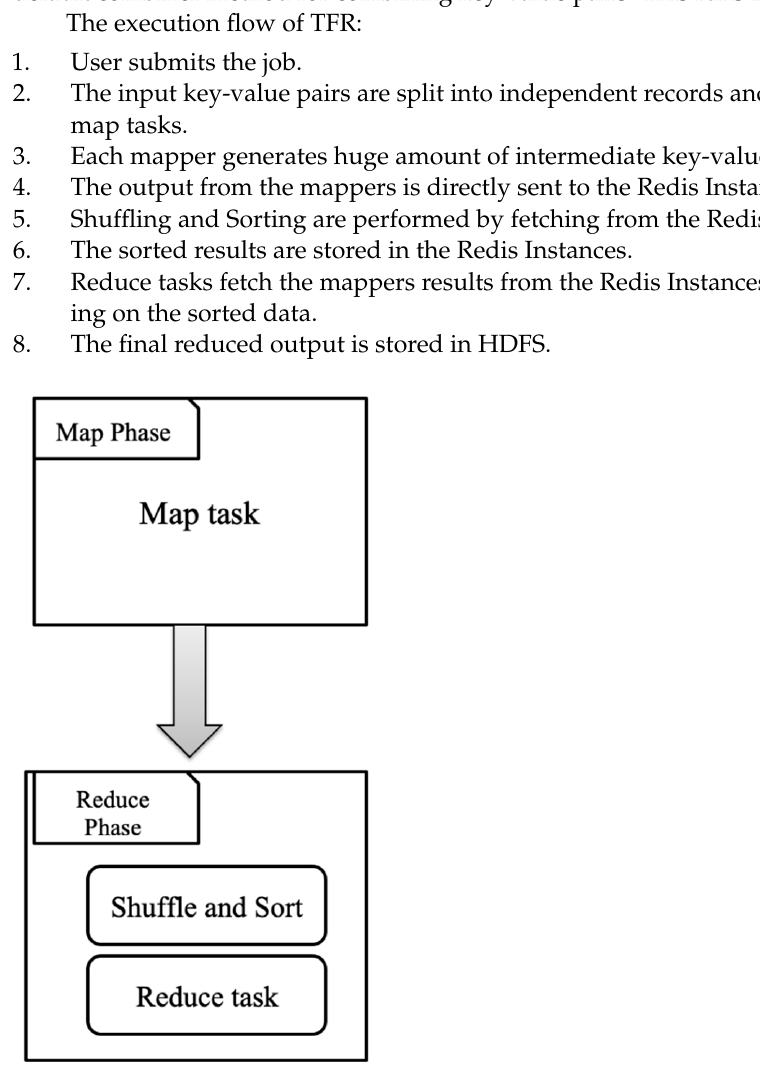
Figure 1. Standard MapReduce execution flow.